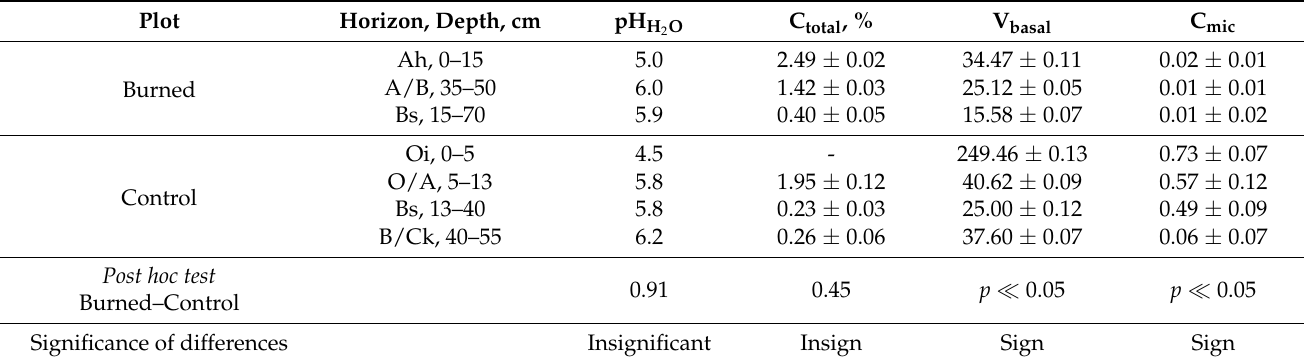
Table 2. General soil